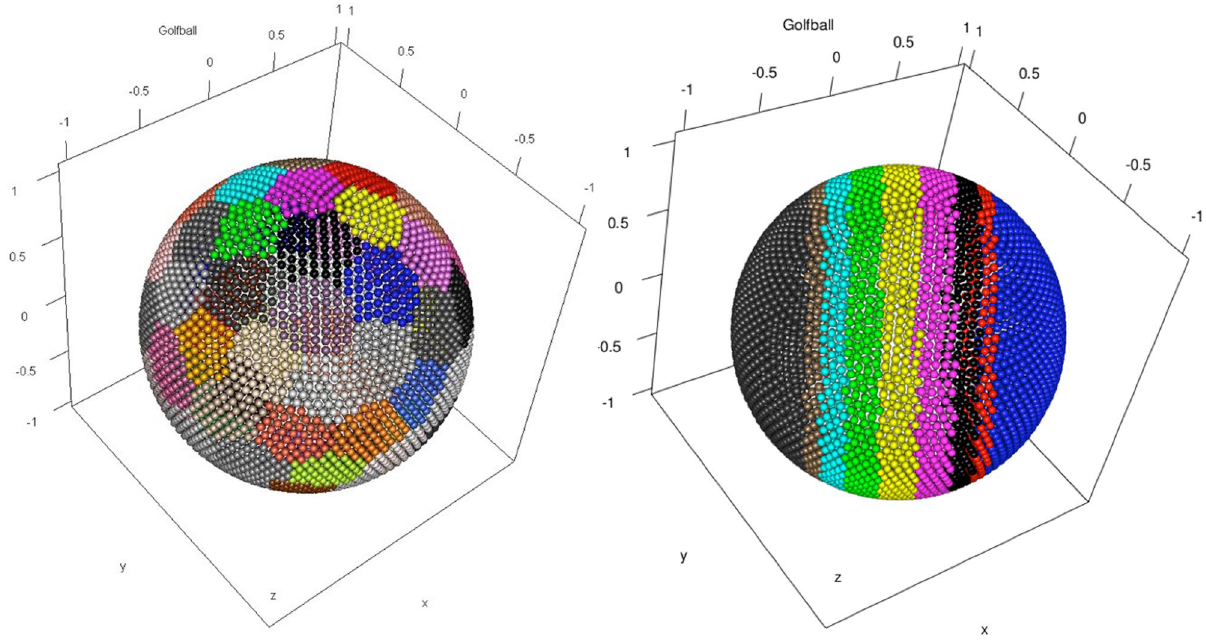
Figure 1. The coloured points of the two SOM clusters of the GolfBall dataset 16 . The figure on the left shows an optimal clustering of 0.83 for the Davies–Bouldin index, and the figure on the right shows the worst case of 11.8 for the Davies–Bouldin